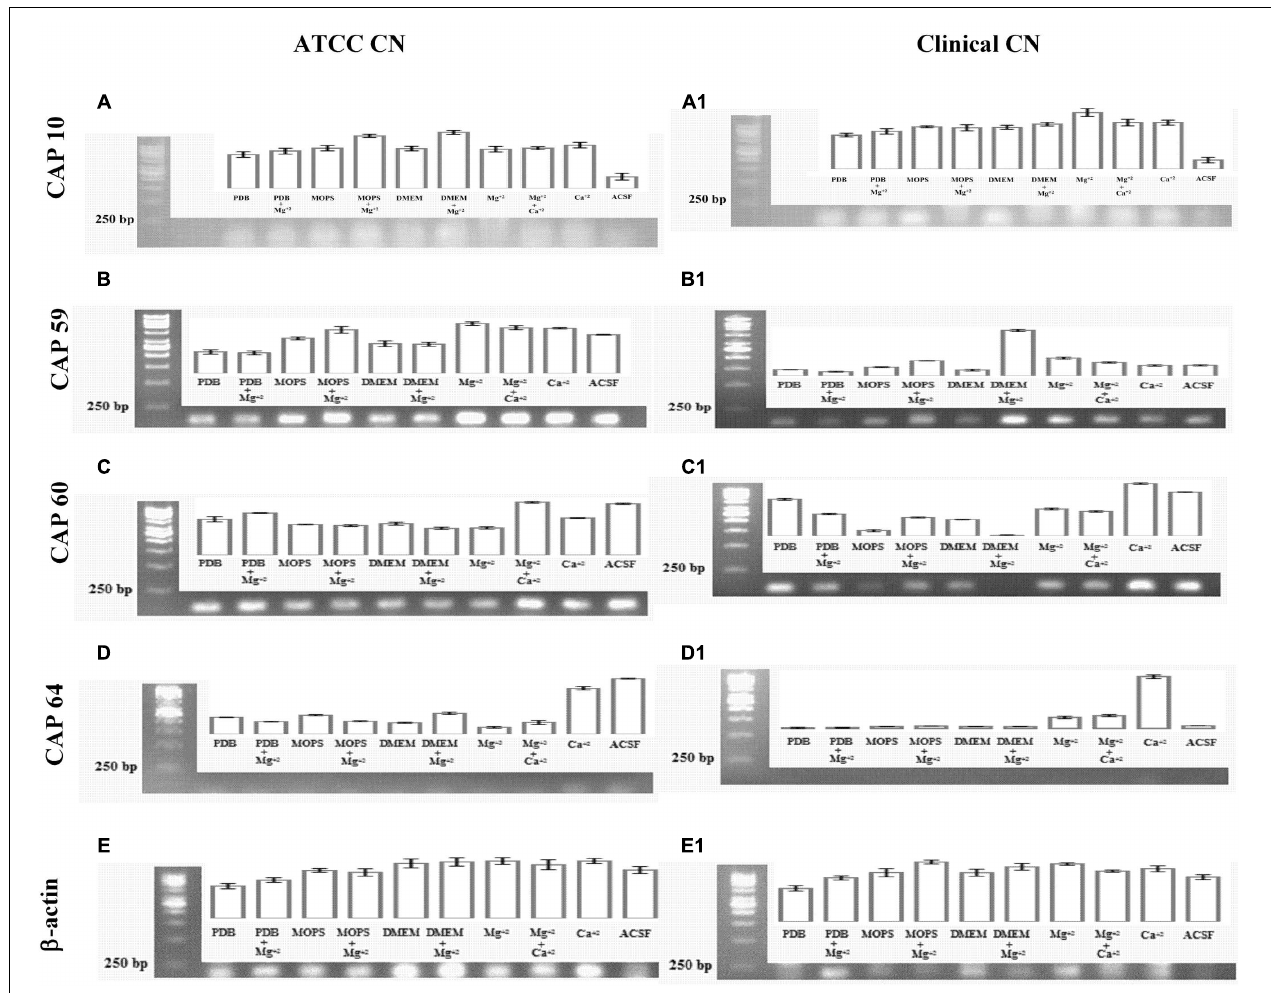
FIGURE 10 | Capsule associated gene expression. CAP gene expression of ATCC C. neoformans : (A) CAP10 gene; (B) CAP59 gene; (C) CAP60 gene; (D) CAP64 gene; (E) β -actin gene. CAP gene expression clinical C. neoformans : (A1) CAP10 gene; (B1) CAP59 gene; (C1) CAP60 gene; (D1) CAP64 gene; (E1) β -actin